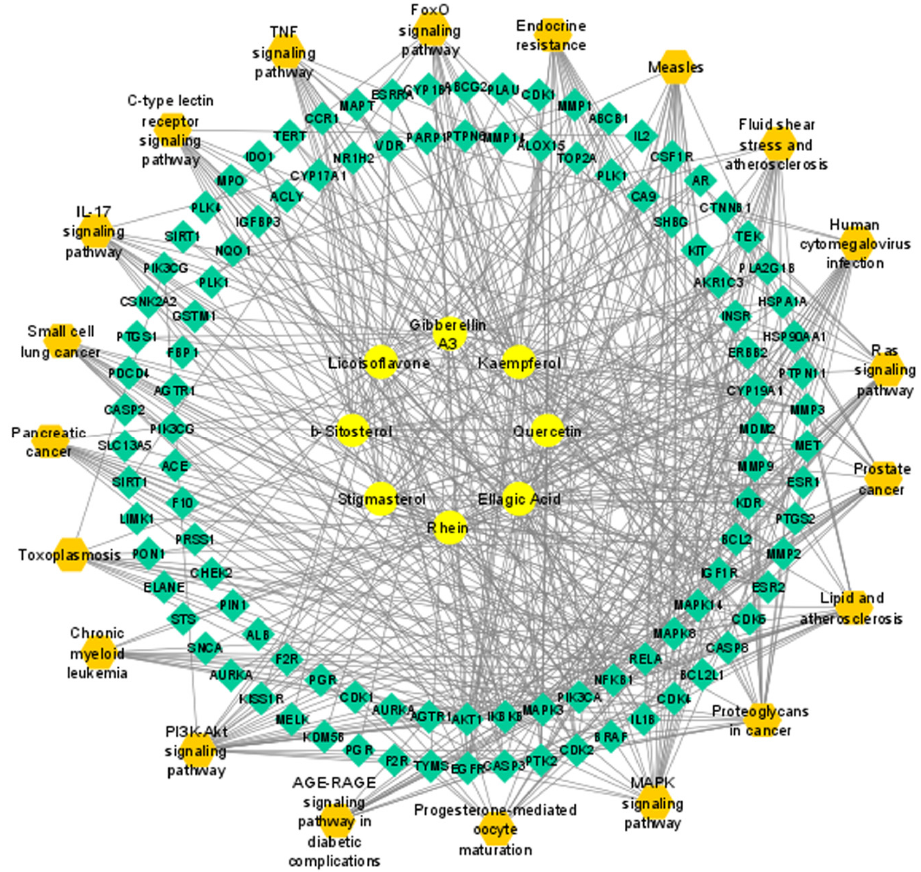
Figure 8. C. fistula ’s compound–target–signaling pathway network to EOC. Candidate active phy- tochemicals shown as ellipses, potential targets represented as diamonds, and pathways repre- sented as hexagons.